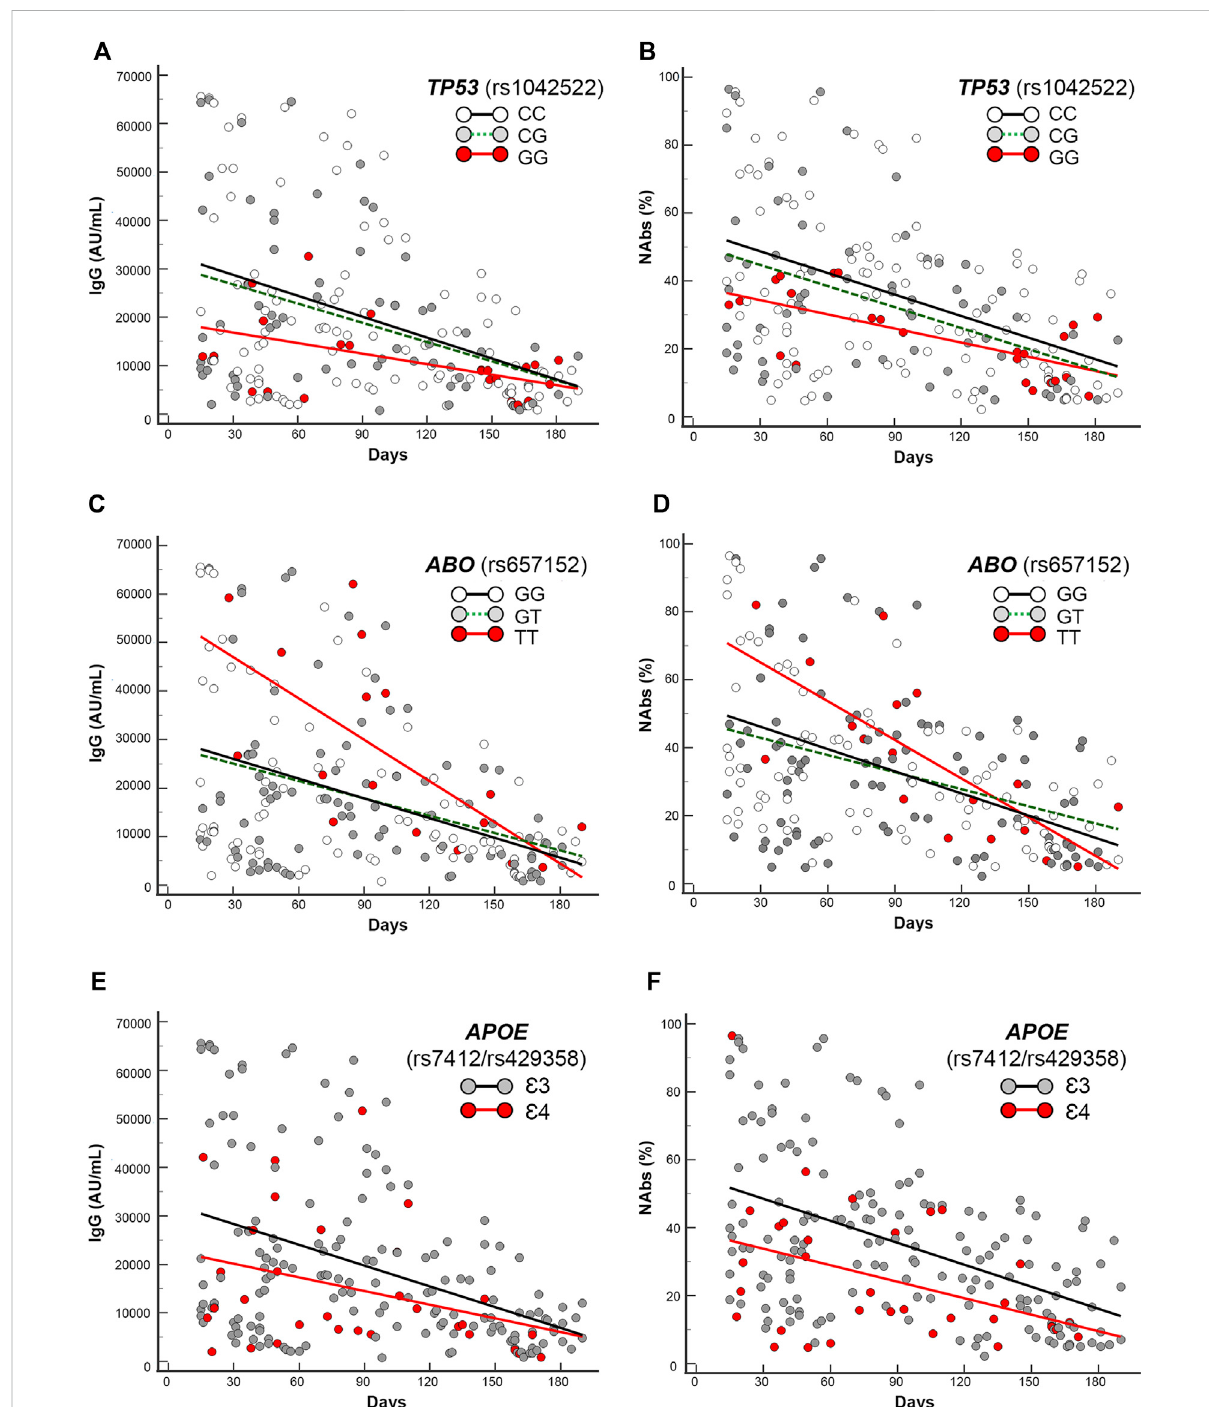
FIGURE 3 Scatter plots and regression analyses of IgG and NAbs levels strati fi ed by the selected gene variants in the whole cohort. (A,C,E) IgG and (B,D,F) NAbs kinetics according to TP53 (rs1042522), ABO (rs657152), and APOE (rs7412/rs429358). Each panel shows the speci fi c regression lines, according to the indicated